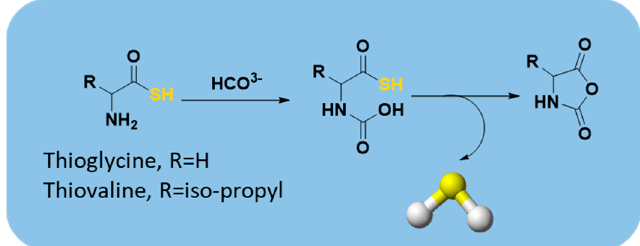
Figure 16. Proposed mechanism for H 2 S release from thioamino acids.